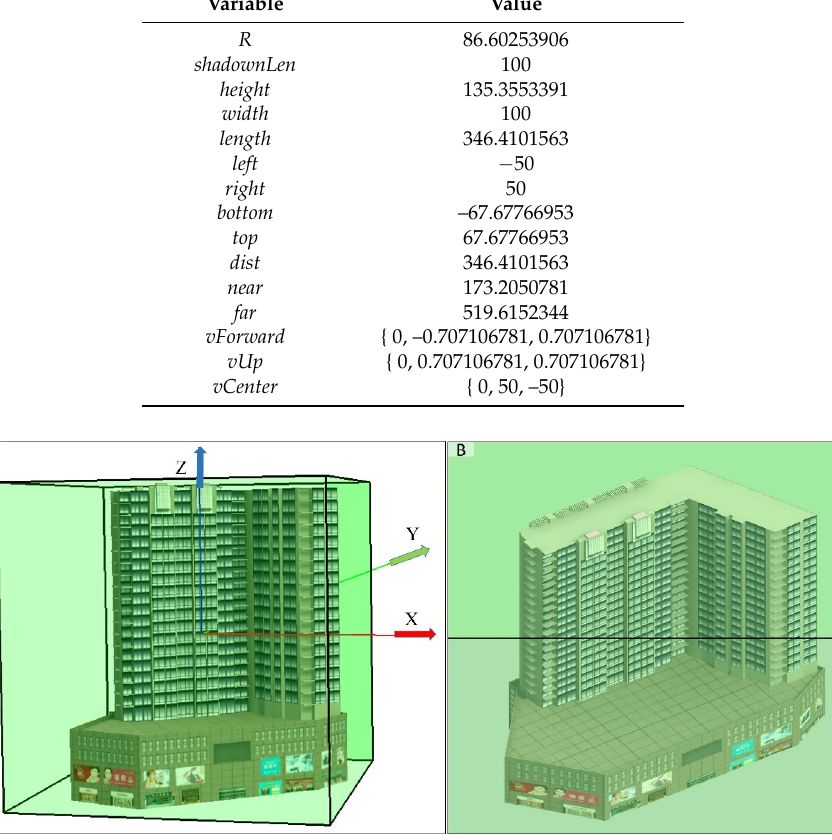
Figure 6. Generating an oblique image from the south–north direction at an elevation angle of 45° using an instantiated oblique image renderer: ( A ) the 3D building model used; ( B ) the oblique image generated.